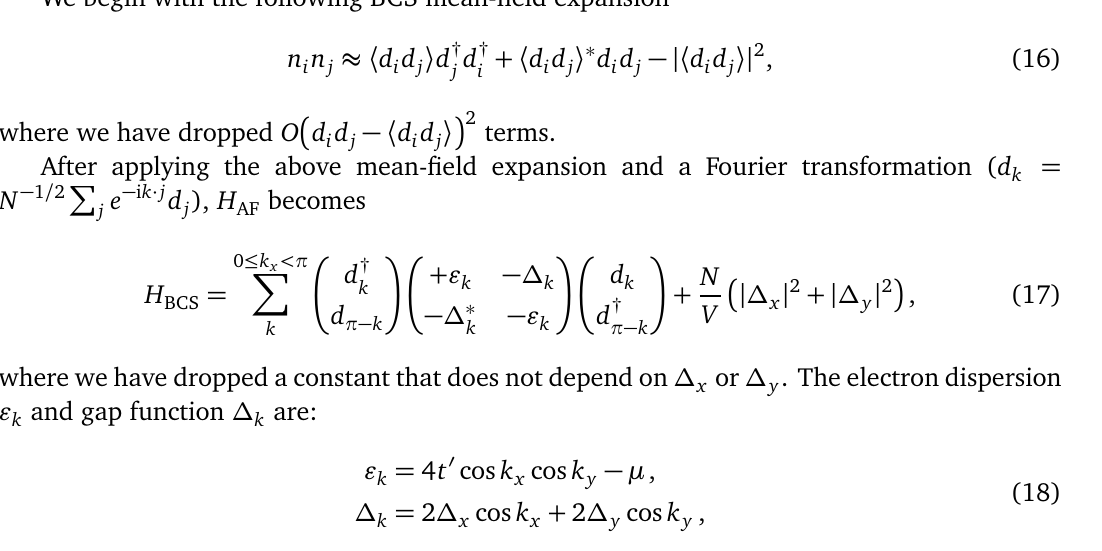
Figure 4: (cid:101) E AF is the ground state energy of H N − 1,0 Eq. (2) ] with N − 1 electrons that are either spin-up on the A sublattice (red sites) or spin-down on the B sublattice (blue sites) and subject to the constraint that there are no fermions on the five sites marked with